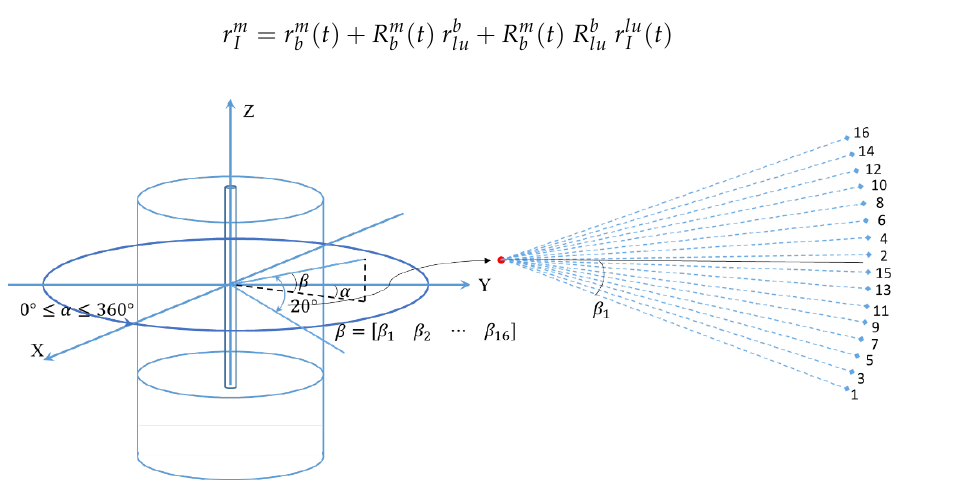
Figure 4. Illustration of a multi-beam spinning LiDAR unit (VLP-16 Puck Hi-Res).